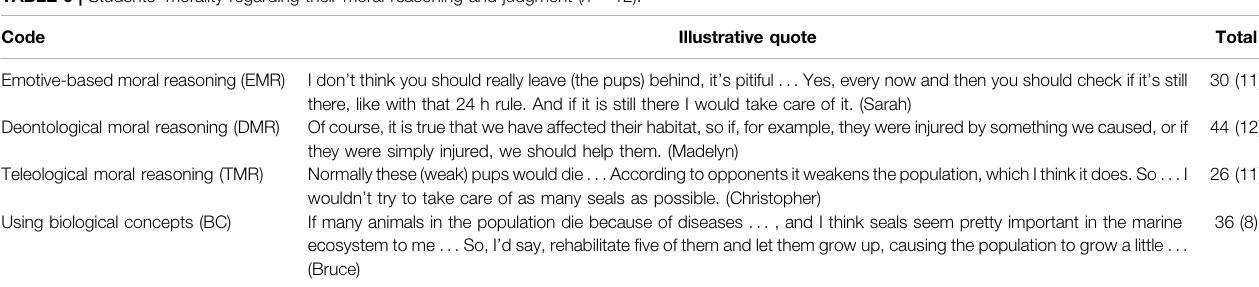
TABLE 6 | Students ’ morality regarding their moral reasoning and judgment ( n (cid:1) 12).